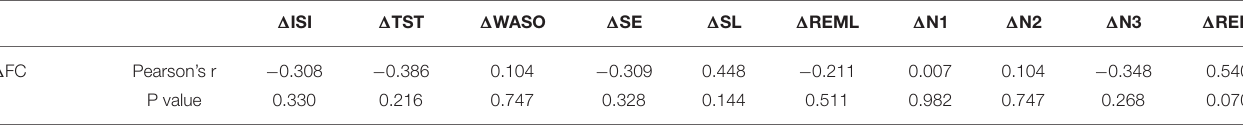
TABLE 3 | Correlation between LC FC changes and clinical parameters. 1 ISI 1 TST 1 WASO 1 SE 1 SL 1 REML 1 N1 1 N2 1 N3 1 REM 1 FC Pearson’s r − 0.308 − 0.386 0.104 − 0.309 0.448 − 0.211 0.330